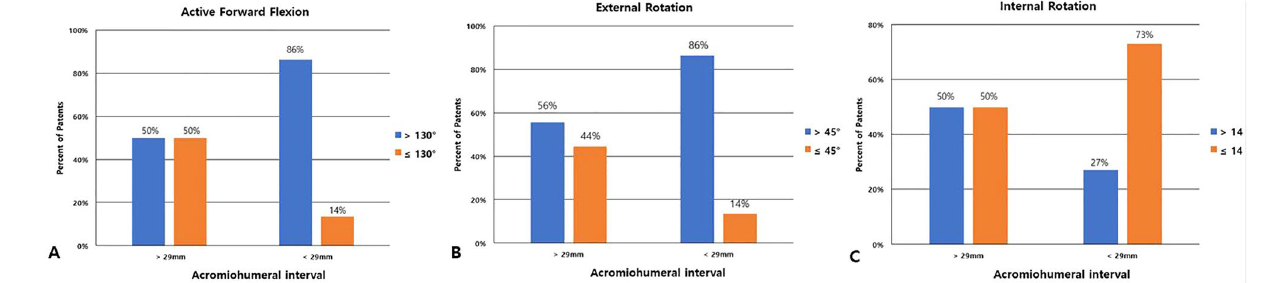
Figure 5. When the postoperative acromiohumeral interval was < 29 mm, then ( A ) nearly 86% of patients achieved > 130° of active forward flexion. ( B ) nearly 86% of patients achieved > 45° of external rotation. ( C ) nearly 73% of patients achieved ≤ 14 of internal